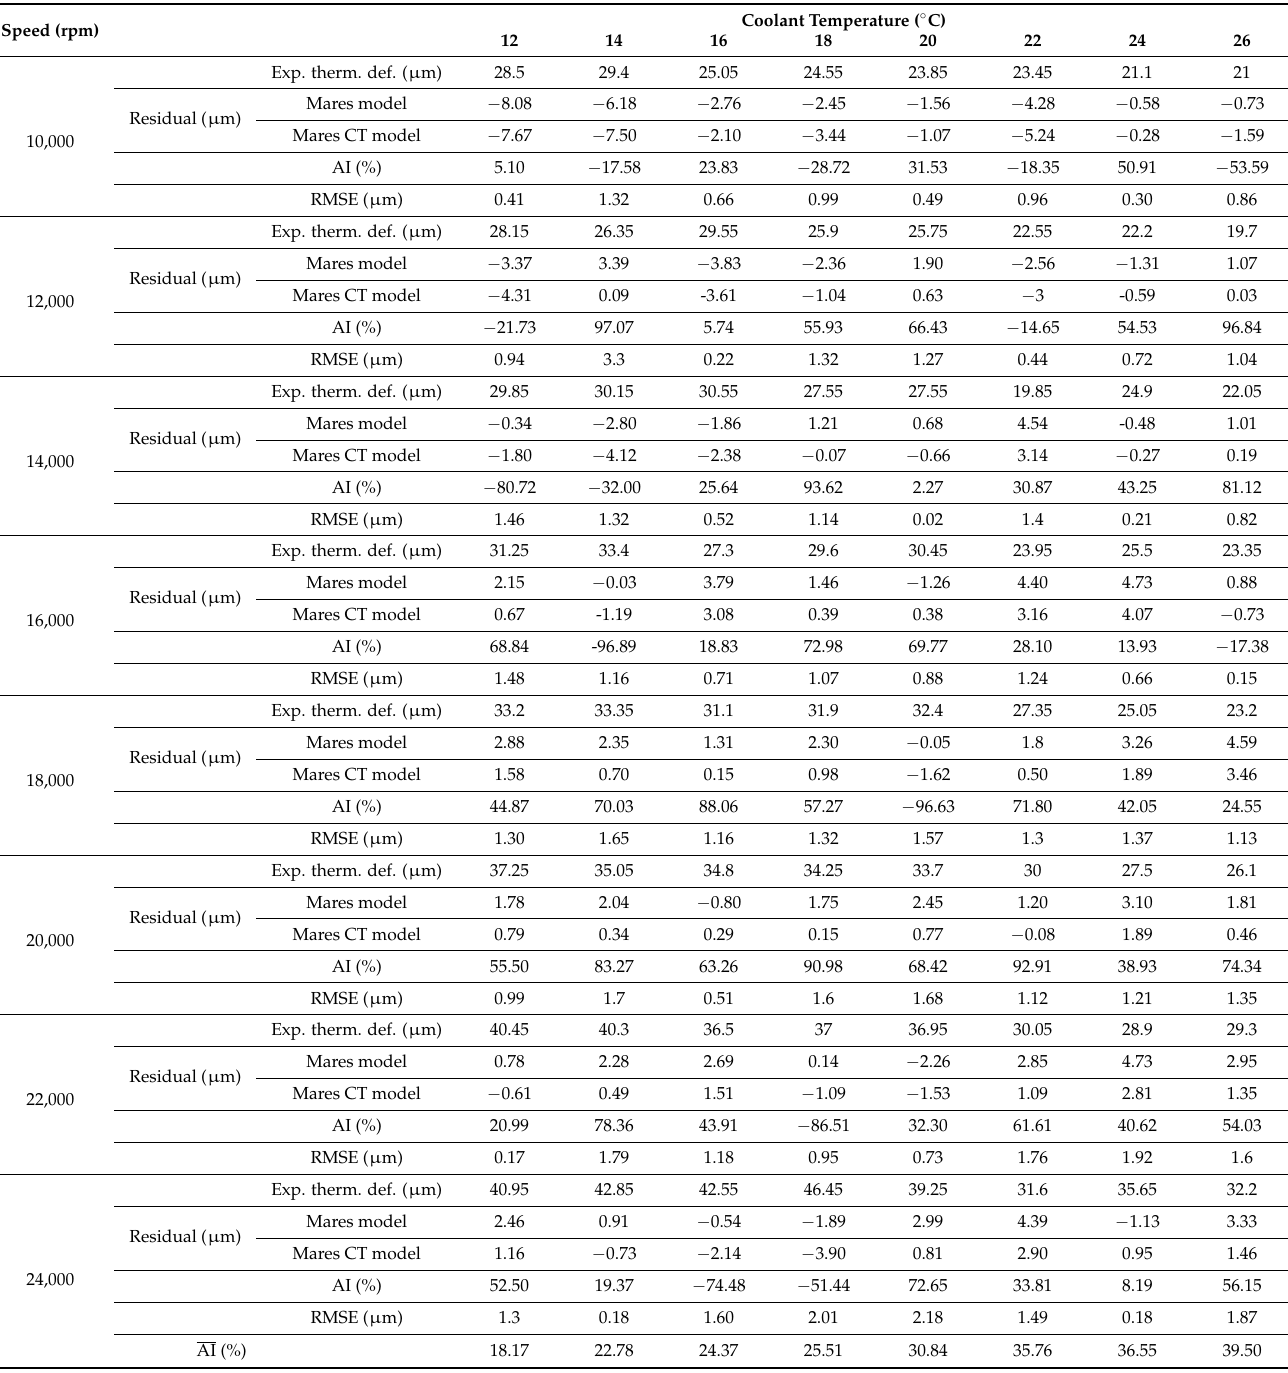
Table 2. Residual thermal errors, AI, RMSE, and AI between the Mares and Mares CT models over the experimental thermal deformation (exp. therm. def.) at different coolant temperatures and spindle rotating speeds at a constant flow rate of 5 LPM and a 26 ◦ C ambient temperature with a standalone built-in spindle